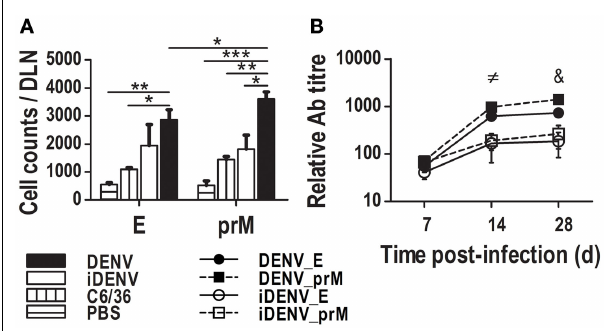
FIGURE 5 | Specific GC B cells and Ab responses to the viral proteins prM and E . DLN from mice inoculated with different stimuli were harvested at day 14 to prepare cell suspensions. Using multimers made of prM- or E-viral proteins, we searched for Ag-specific GC B cells by flow citometry. (A) Total specific GC B cells per antigenic protein per LN show a higher number for prM-specific GC B cells than for E-specific GC B cells. Data shown are pooled from two independent experiments, represent the mean ± SEM, and were analyzed with two-way ANOVA with the Bonferroni post-test. * P < 0.05, ** P < 0.01, *** P < 0.001. (B) Specific (IgG) Ab titers were determined for prM and E viral Ags, DENV induces a bigger quantity of them in comparison with iDENV. Data represent the mean ± SEM of the titers minus the titers of control C6/36, and are representative from two independent experiments. Mice were inoculated at day 0 and boosted at day 7. ̸ = DENV_E vs iDENV_E, and DENV_E vs iDENV_prM P < 0.05; DENV_prM vs iDENV_E, and DENV_prM vs iDENV_prM P < 0.001 & DENV_E vs iDENV_prM P < 0.05; DENV_E vs iDENV_E P < 0.01; DENV_E vs DENV_prM,